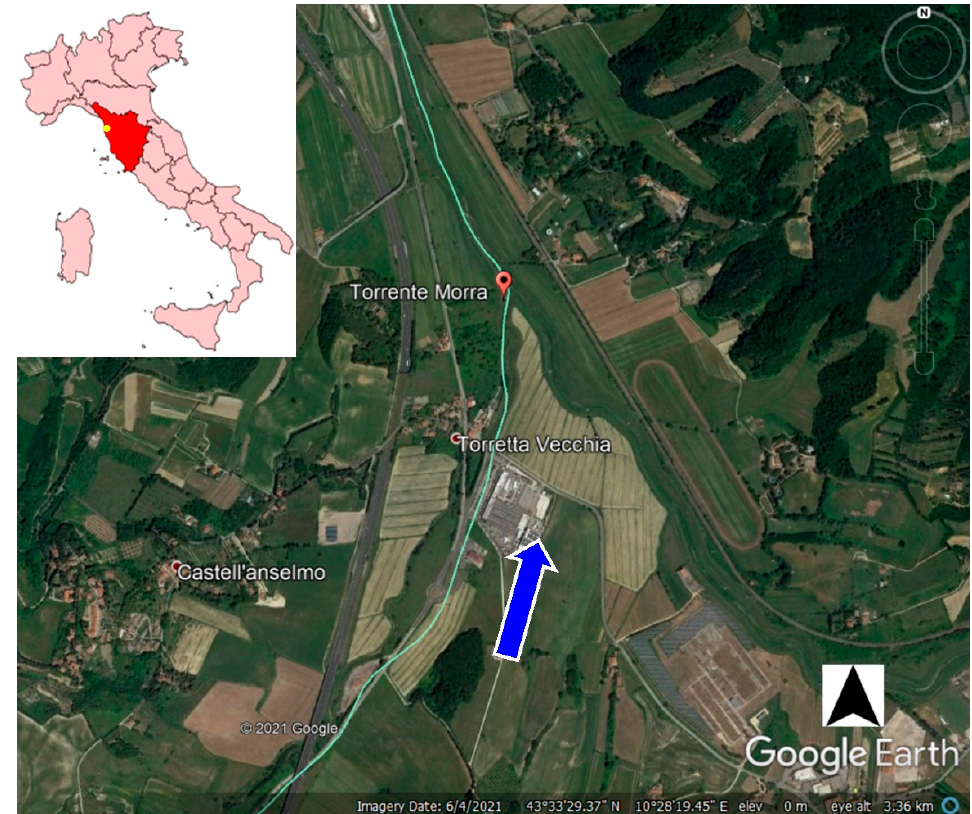
Figure 1. Study area (Central Tuscany, Northern Italy) overview. The soft green line indicates Morra Creek, while the blue arrow indicates the flow direction.